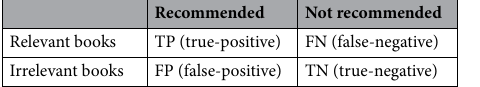
Table 2. Evaluation metrics table 11